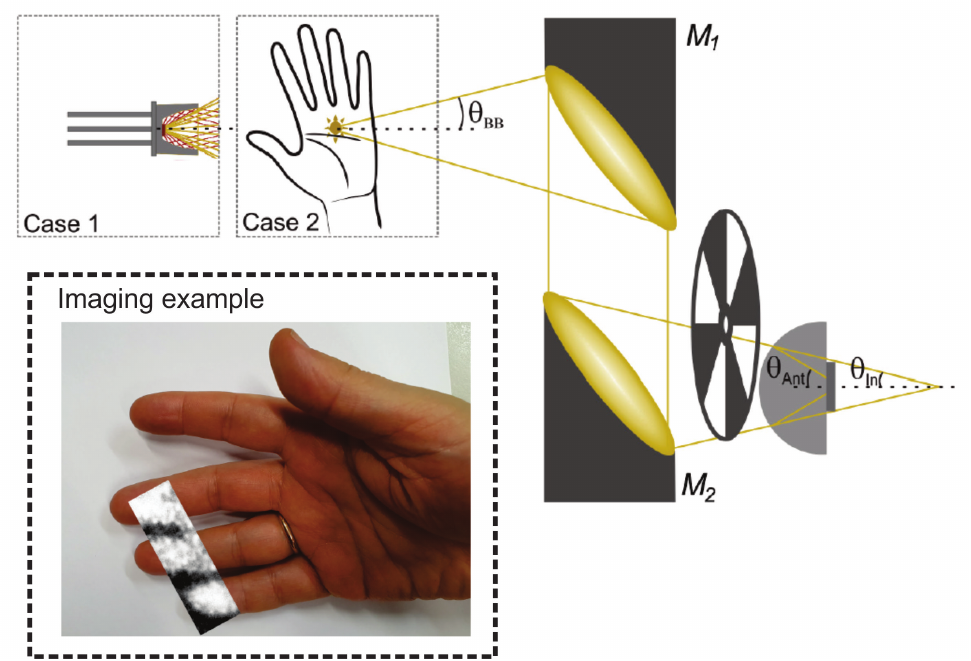
Figure 8. Detection of thermal radiation with a broadband nanometric FET [419]. The main panel shows the setup for the detection of radiation emitted from ( Case 1 ) a ceramic heat source (embedded in a reflector) or ( Case2 ) the human body, here, the palm of a hand. The heater, respectively, the hand, was placed on a xy -translation stage for raster-scan imaging. The radiation was guided by two parabolic mirrors and through a mechanical chopper to the detector, where it impinged via a Si substrate lens, attached to the backside of the nanometric FET chip, onto the antenna-embedded transistor. The angles shown are various acceptance angles used for the calculation of the expected noise-equivalent temperature difference (NETD). Inset: Raster-scan image of three fingers of a hand. The measurement was performed at ambient temperature. The black-and-white plot of the 25 × 75- pixel image (white indicating an elevated temperature; black representing room temperature) is superimposed on a photograph of the hand. Figure modified from Ref.